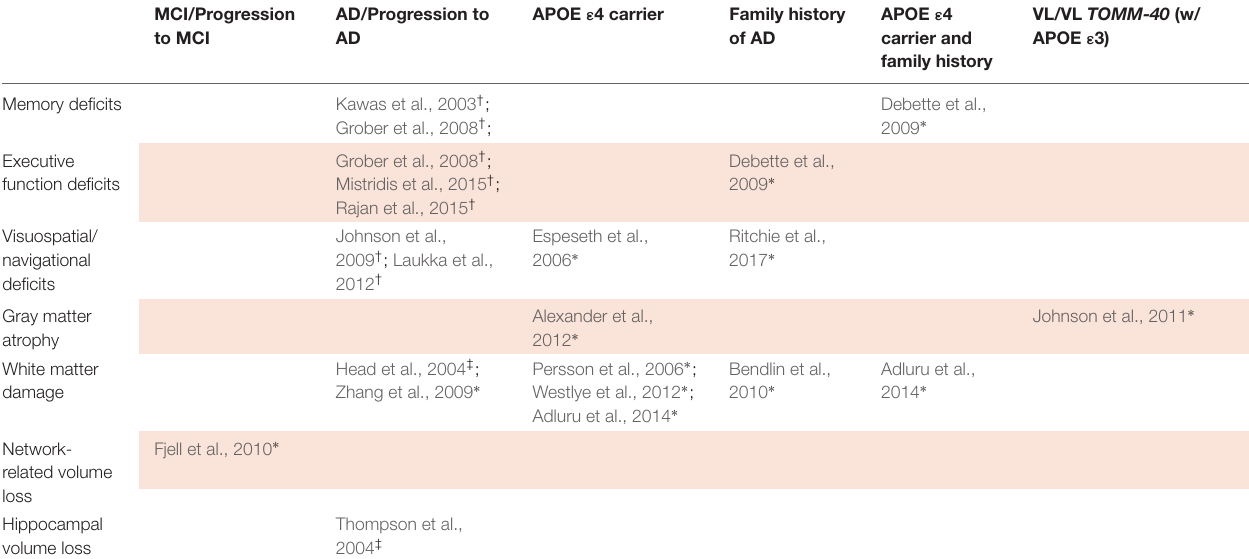
TABLE 1 | Studies of healthy versus pathological